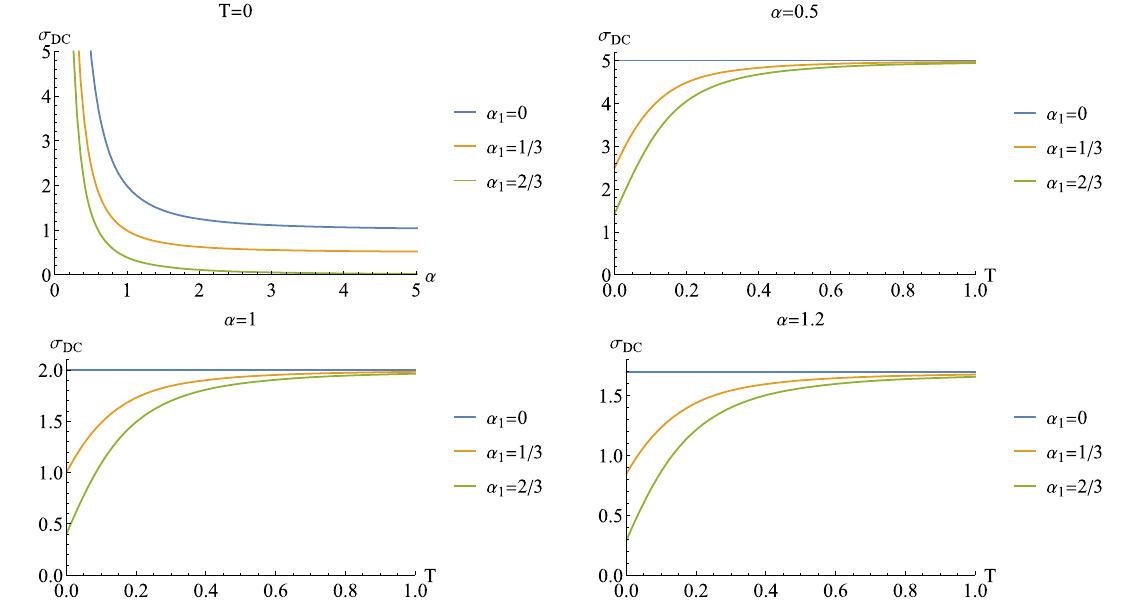
Fig. 1 The DC conductivity with the α 1 coupling turned on by setting T = 0 while α vary and by setting α = { 0 . 5 , 1 , 1 . 2 } while T vary. Here we have abbreviated the two dimensionless quantities { T /μ,α/μ } to { T ,α